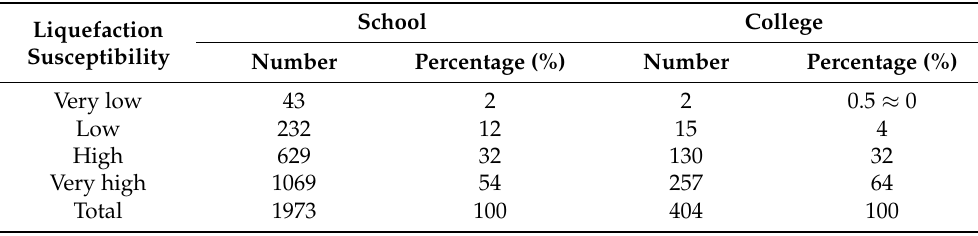
Table 6. Schools and colleges of Kathmandu Valley falling in a different zone of liquefaction suscepti-